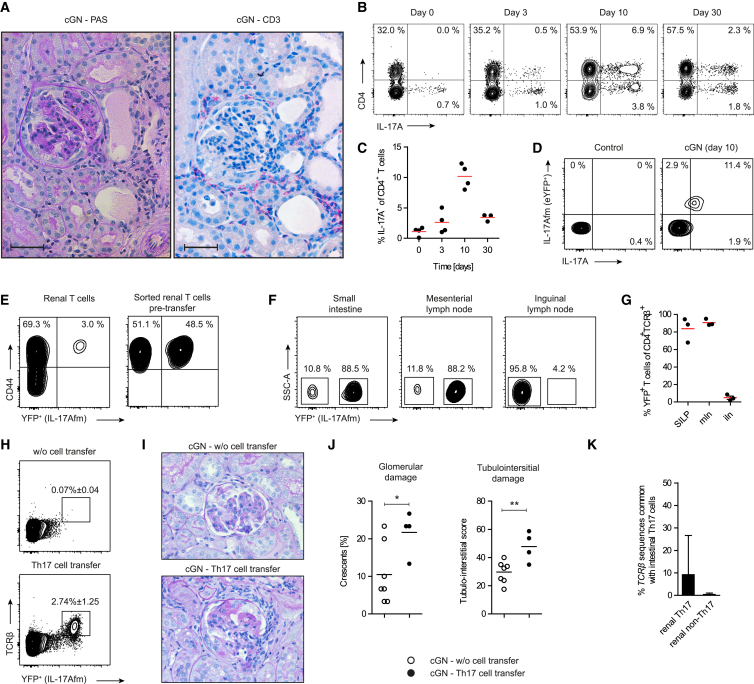
Renal Th17 Cells Have Gut-Homing Properties(A) PAS and CD3 staining of renal tissue sections of mice at day 10 after induction of crescentic glomerulonephritis (cGN). Scale bar, 20 μm.(B) Intracellular cytokine staining and FACS analyses of CD3+ T cells in the course of cGN (day 0–30).(C) Quantification of IL-17A+CD4+ Th17 cells in the course of cGN.(D) Flow cytometry of renal CD4+ T cells from Il17a fate reporter mice (Il17aCre × R26ReYFP) and intracellular staining for IL-17A expression.(E) CD44high Th17 cells (YFP+) and CD44high non-Th17 cells (YFP−) were FACS sorted from the kidneys of Il17a fate reporter mice with cGN. Cells were mixed in a 1:1 ratio and transferred into Tcrα−/− recipients.(F and G) After 12 weeks, small intestinal lamina propria (SILP), mesenteric lymph nodes (mln), and inguinal lymph nodes (iln) were analyzed for the abundance of Th17 cells (YFP+) and non-Th17 cells (YFP−) by flow cytometry.(H) Transfer of FACS-sorted Th17 cells (CD44highYFP+) from the small intestine of Il17a fate reporter mice into Tcrα−/− recipients and cGN induction 5 weeks after cell transfer. At day 8 after cGN induction, the kidneys were analyzed for gut-derived Th17 cells.(I and J) (I) PAS-stained kidney sections and (J) quantification of renal damage of mice after Th17 cell transfer and subsequent cGN induction.(K) cGN was induced in Il17a fate reporter mice. At day 10, renal Th17 cells (YFP+), renal non-Th17 cells (YFP−), and small-intestinal Th17 cells were FACS sorted and analyzed for TCRβ sequences using the ImmunoSEQ platform. Common sequences of intestinal Th17 and renal Th17 or renal non-Th17 cells were calculated. Error bars indicate SEM.See also Figure S2. Data are representative of at least two independent experiments. Symbols represent individual data points with the mean as a horizontal line, bars represent mean values. ∗p < 0.05, ∗∗p < 0.01.